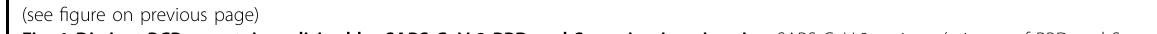
Fig. 1 Distinct BCR repertoires elicited by SARS-CoV-2 RBD and S vaccinations in mice. SARS-CoV-2 antigen (mixture of RBD and S proteins) positive B GC cells in lymph nodes from vaccinated mice were sorted by fl ow cytometry and then placed into the 10× Chromium (10× Genomics) for high-throughput single-cell V(D)J sequencing. a Pie charts show clonal expansion of SARS-CoV-2-speci fi c B cells in the germinal center for IGVH (upper panel) or IGVL (bottom panel). Colored slices are proportional to the number of clonal relatives. See also related Supplementary Table S1. b Paired V gene use in B cell repertoire induced by SARS-CoV-2 vaccines based on RBD (left) or S (right). c Proportions of expressed, binding, and neutralizing antibodies in the top 100 frequent recovered mAbs in antibody repertoire. See also related Supplementary Fig. S5. d Proportions of the indicated antigenic site-directed, non-neutralizing and neutralizing antibodies in 53 recovered S-reactive mAbs from the S group. See also related Supplementary Fig. S5. e The gene germline identity and the CDR3 length of VH and VL of all synthesized mAbs from RBD and S groups is shown on the top and bottom, respectively. f Competition heatmap of representative RBD-reactive neutralizing mAbs from RBD and S repertoires with hACE2 and reference mAbs CB6 (class 1), B38 (class 1), CovA2-39 (class 2), P2B-2F6 (class 2), S309 (class 3), REGN10987 (class 3), EY6A (class 4), and S2A4 (class 4). g Structural depiction of reference mAbs CB6 (red, PDB 7C01), P2B-2F6 (magenta, PDB 7BWJ), S309 (cyan, PDB 6WPS), and S2A4 (yellow, PDB 7JVC) RBD-binding epitopes. RBD residues involved in hACE2 binding was colored as blue. Representative RBD-reactive neutralizing mAbs were classi fi ed based on their competition with hACE2 and reference mAbs binding to RBD. A dotted circle indicates a deduced possible epitope of VH9-3 mAbs on RBD that locates between P2B-2F6 and S309 epitopes and to some extent overlaps with both epitopes but does not overlap with hACE2-binding site. For c , d , f , data are one representative result of two or three independent experiments. For d , comparison was performed by Student ’ s t- test (unpaired,